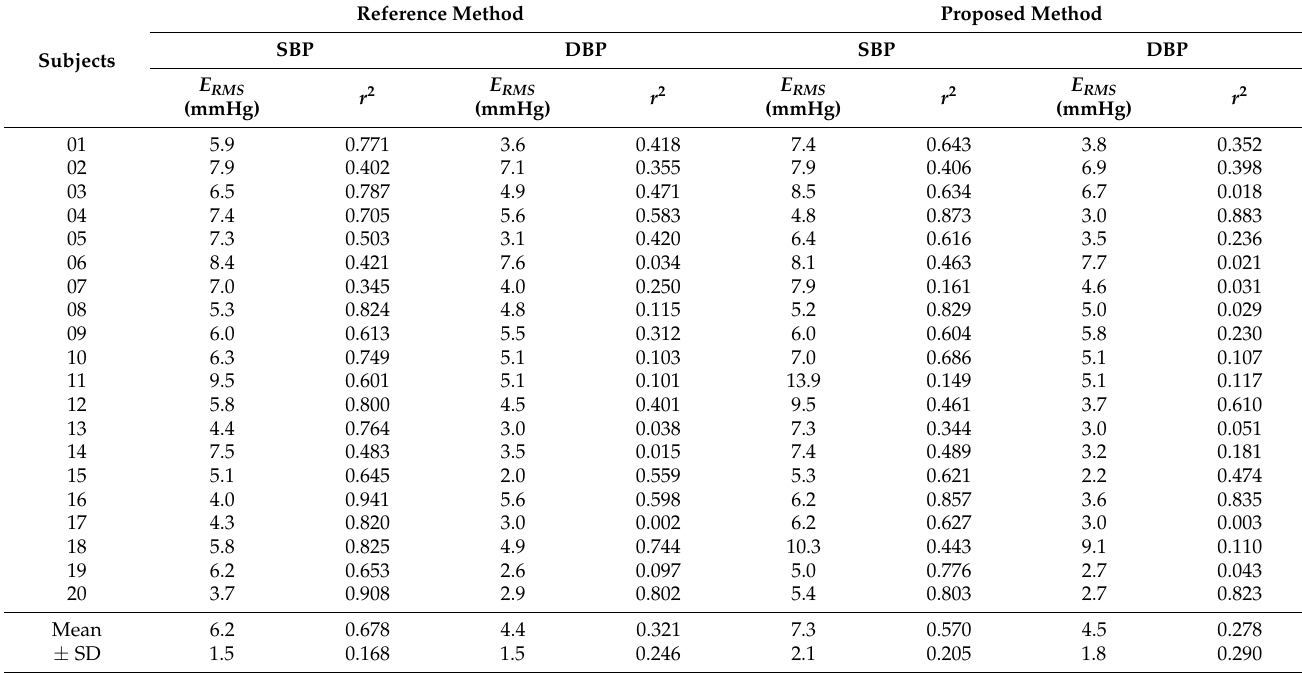
Table 4. Results of estimated SBP and DBP with Equation (5) for the reference and proposed methods.